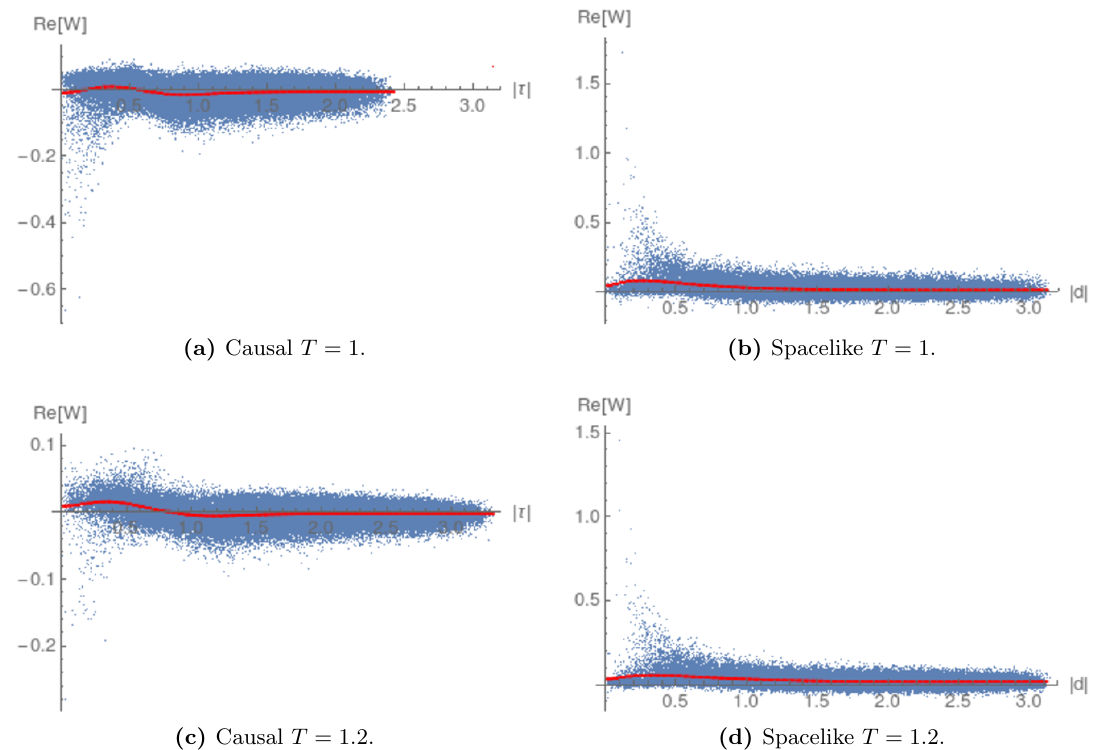
Figure 21. m = 0 ; N = 32000, in 4d de Sitter. Re[ W selected pairs, and the red curve represents the mean values with the SEM.